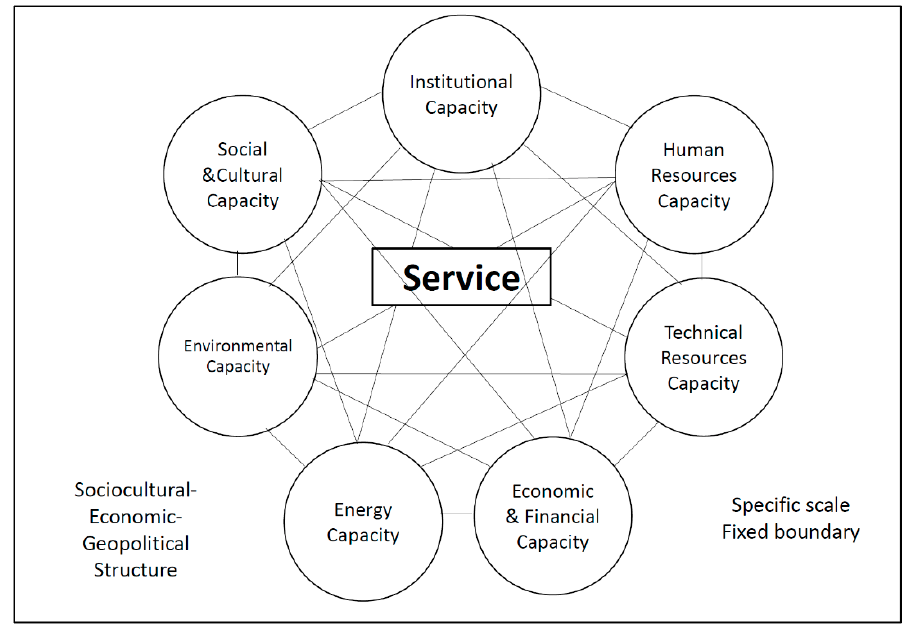
Figure 1. Seven interconnected categories of capacity considered for the delivery of a specific community service in an environment with a specific structure, context, and scale.